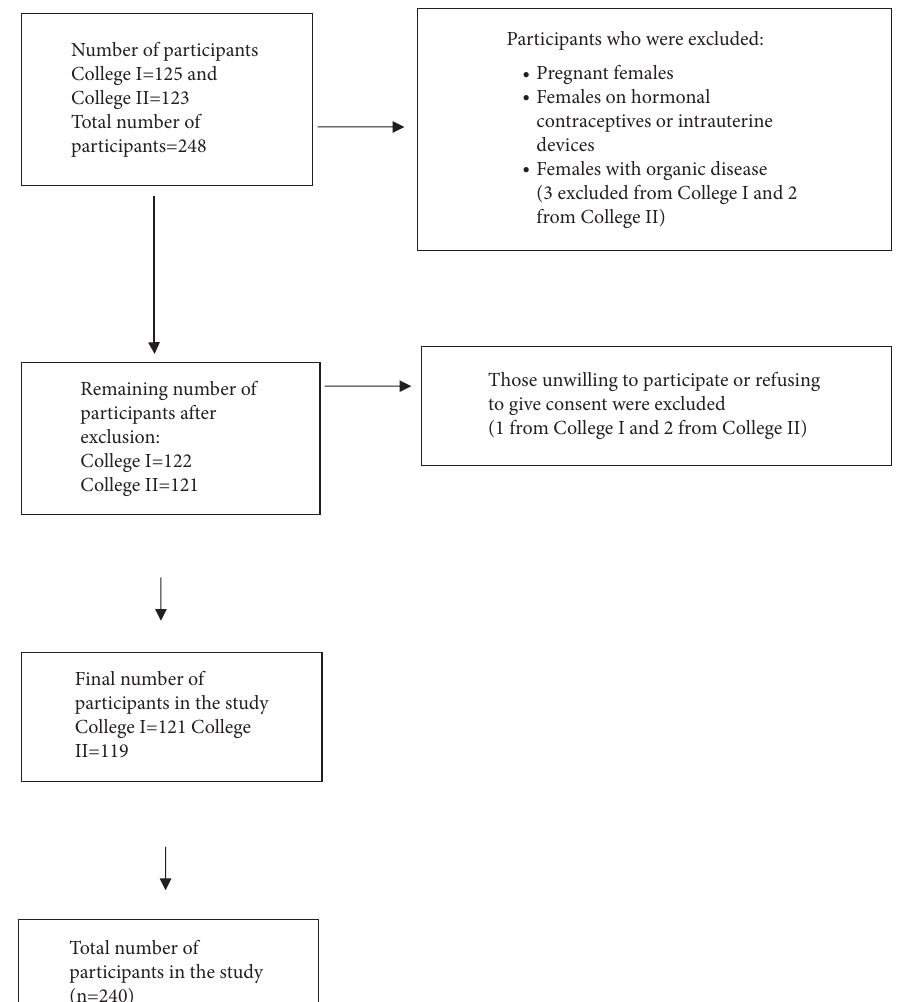
Figure 1: Flow diagram showing the selection of